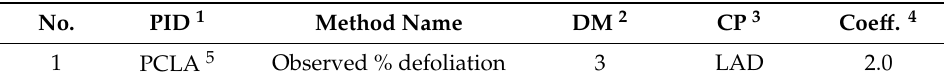
Table 2. Information and format of the pest definition file for the CSM-CERES-Beet (Cropping System Model-Crop Environment Resource Synthesis-Beet) model, used for defining coupling point and damage method in the crop model programming code